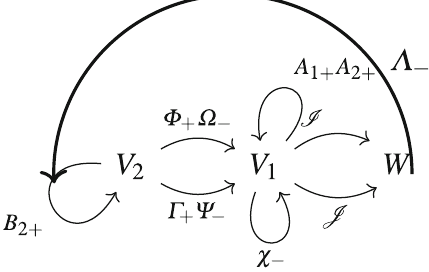
Fig. 1 Quiver diagram encoding D2-branes effective